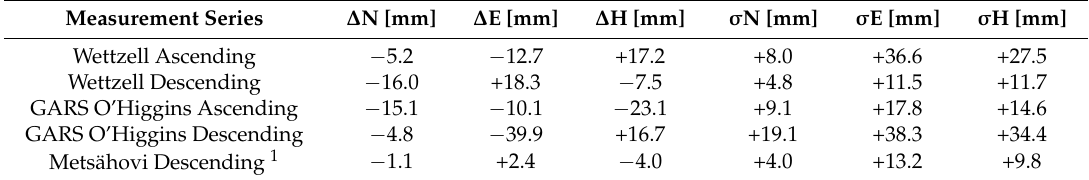
Table 7. Differences of the TerraSAR-X coordinates and the reference coordinates in the global ITRF2014 expressed in local north, east and height. The variances of the TerraSAR solution mark the 95% confidence interval of the estimated